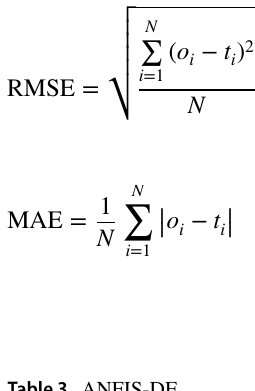
performance evaluation for various input combinations